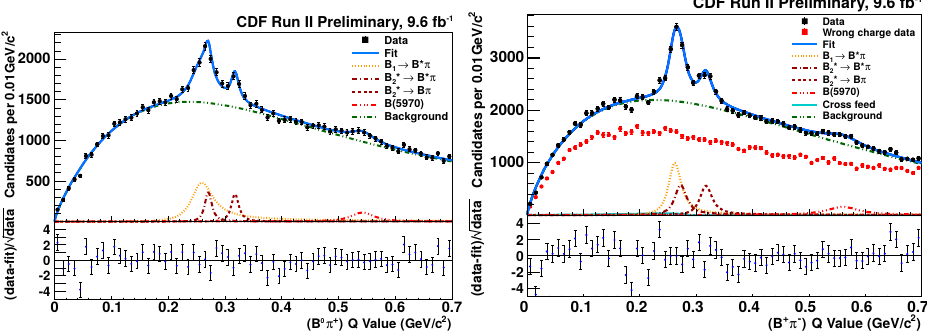
Figure 9. New B state observed at CDF at a Q-value near 0.6 GeV / c 2 . The two peaks around 0.3 GeV / c 2 arise from known